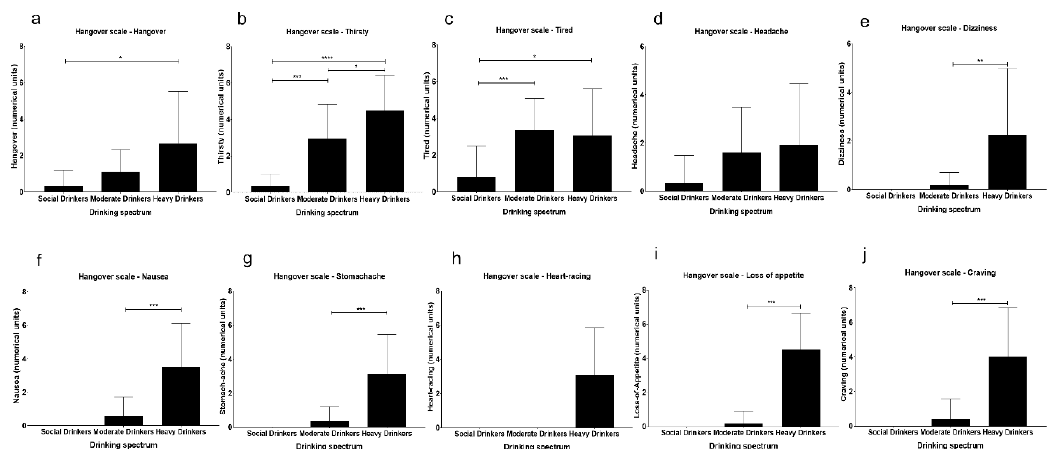
Figure 1. Levels of hangover measures in social / light drinkers (SD), moderate drinkers (MD), and heavy drinkers (HD). ( a ): Hangover measure “Hangover”. ( b ): Hangover measure “Thirsty”. ( c ): Hangover measure “Tired”. ( d ): Hangover measure “Headache”. ( e ): Hangover measure “Dizziness”. ( f ): Hangover measure “Nausea”. ( g ): Hangover measure “Stomachache”. ( h ): Hangover measure “Heart-racing” ( i ): Hangover measure “Loss of appetite”. ( j ): “Craving”, “loss of appetite”, and “thirsty” measures showed moderate level of hangover severity in heavy drinkers (Table 2). Data are presented